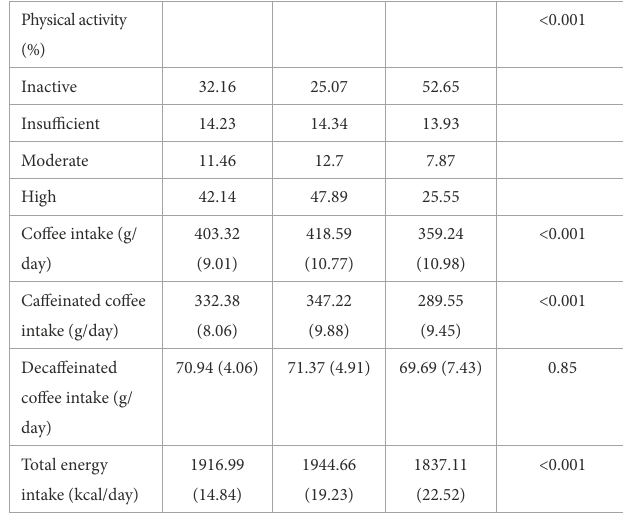
TABLE 1 Characteristics of the study subjects according to frailty (weighted N =